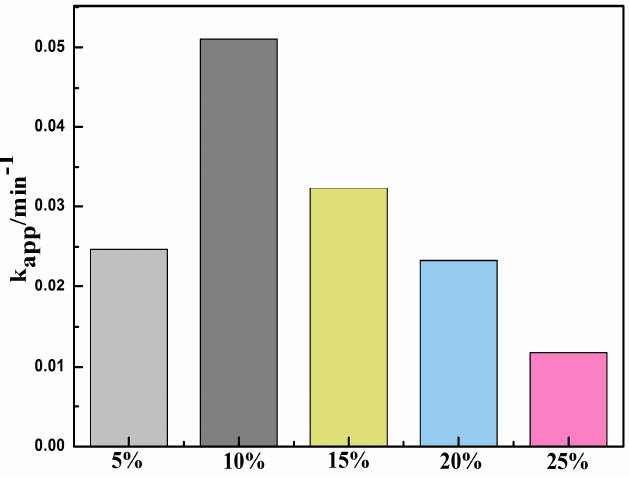
Figure 8. Apparent rate constants for the photocatalytic degradation of MB under the irradiation of visible-light.